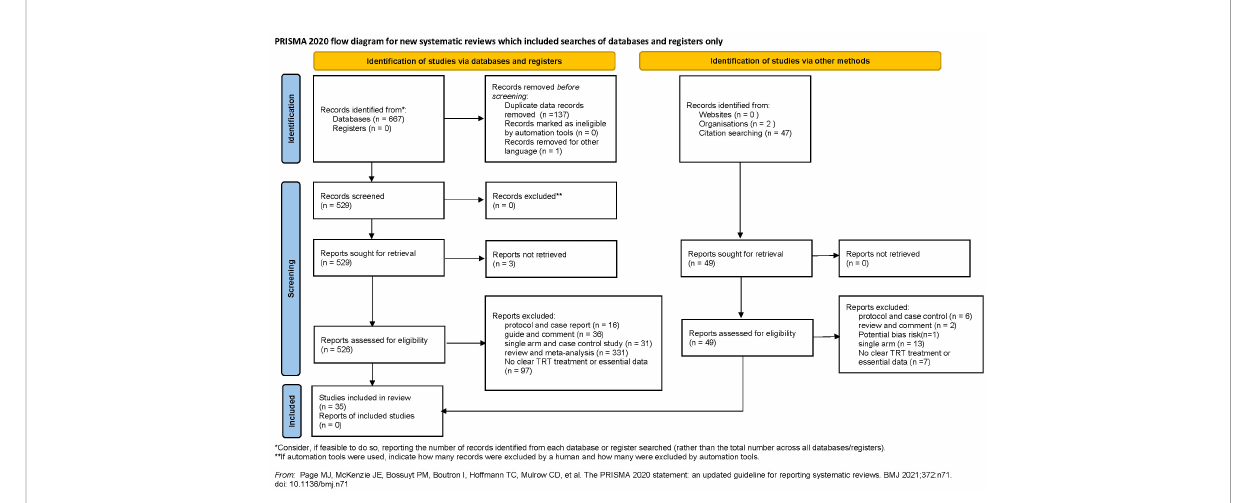
FIGURE 1 Preferred Reporting Items for Systematic Reviews and Meta-analyses fl ow diagram of study selection